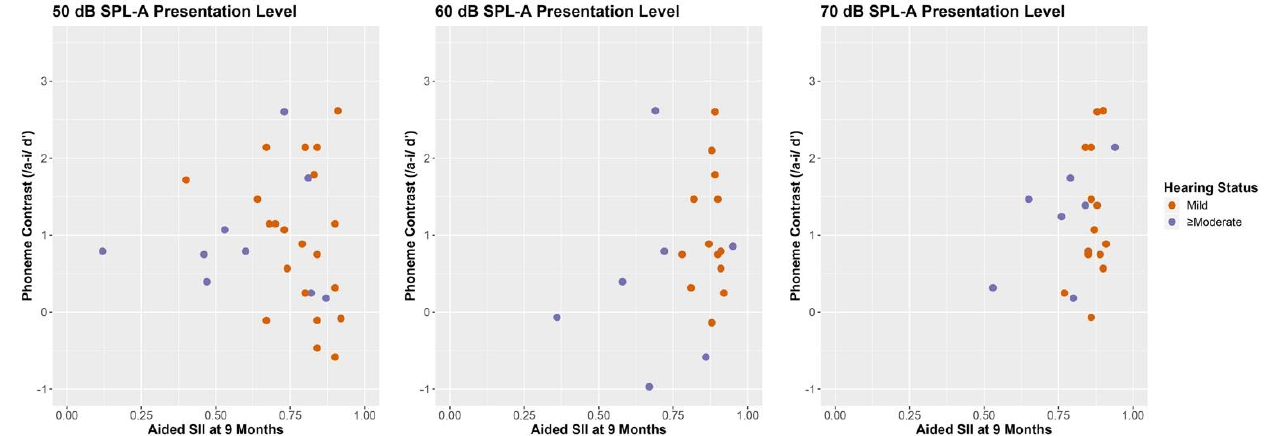
Figure 6. Aided SII at 9 months and speech perception for /a-i/ by presentation level. Note: Speech Intelligibility Index (SII); Sound Pressure Level A-Weighted (SPL-A); Conditioned Head Turn (CHT); Aided speech intelligibility measured at the time of CHT and as a function of CHT discrimination for children with hearing loss (mild in orange, and ≥ moderate in purple).